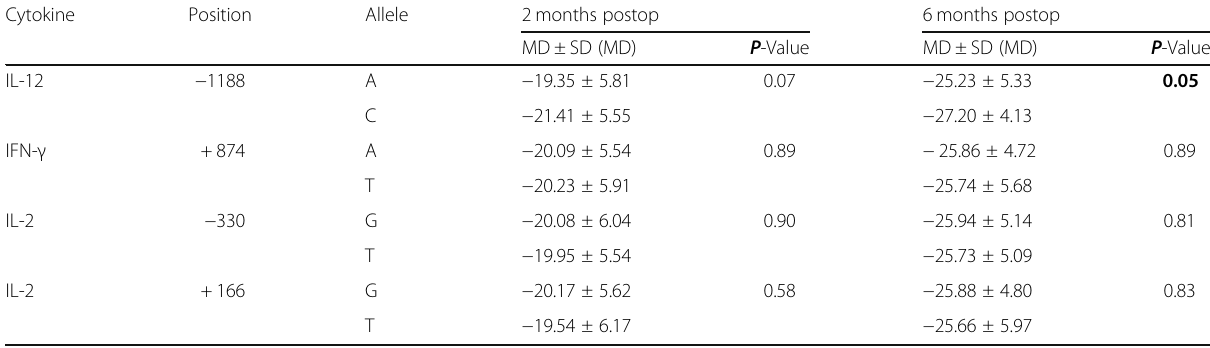
Table 5 Association between cytokine allele frequencies and 2 months or 6 months postop OSW changes in IVDD patients